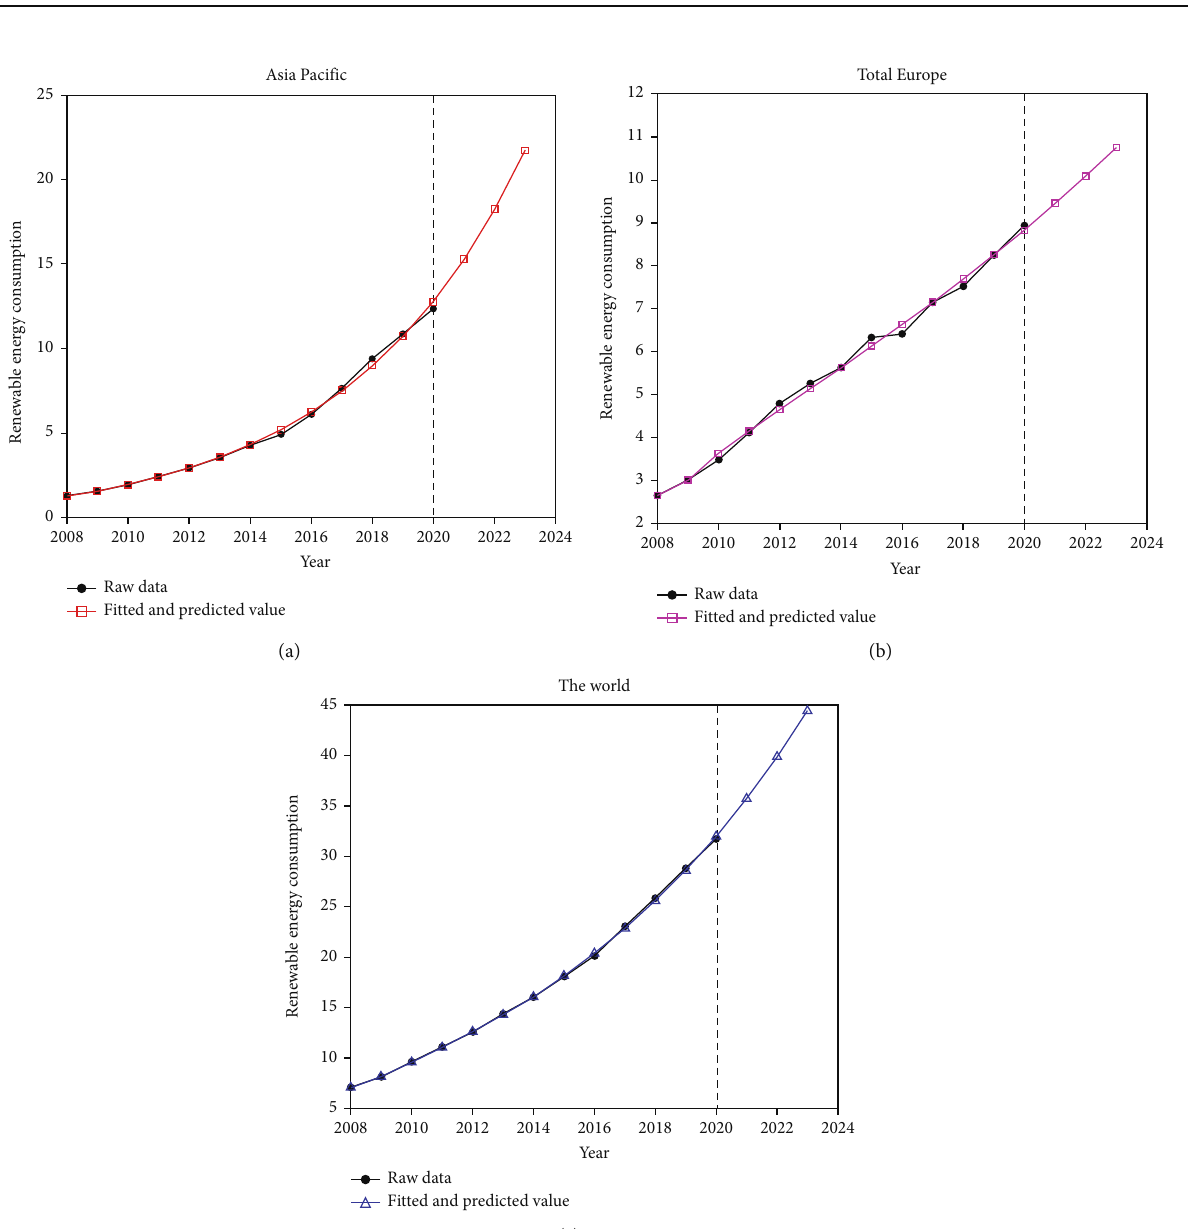
Figure 12: Predictions for the renewable energy consumption over the next 3